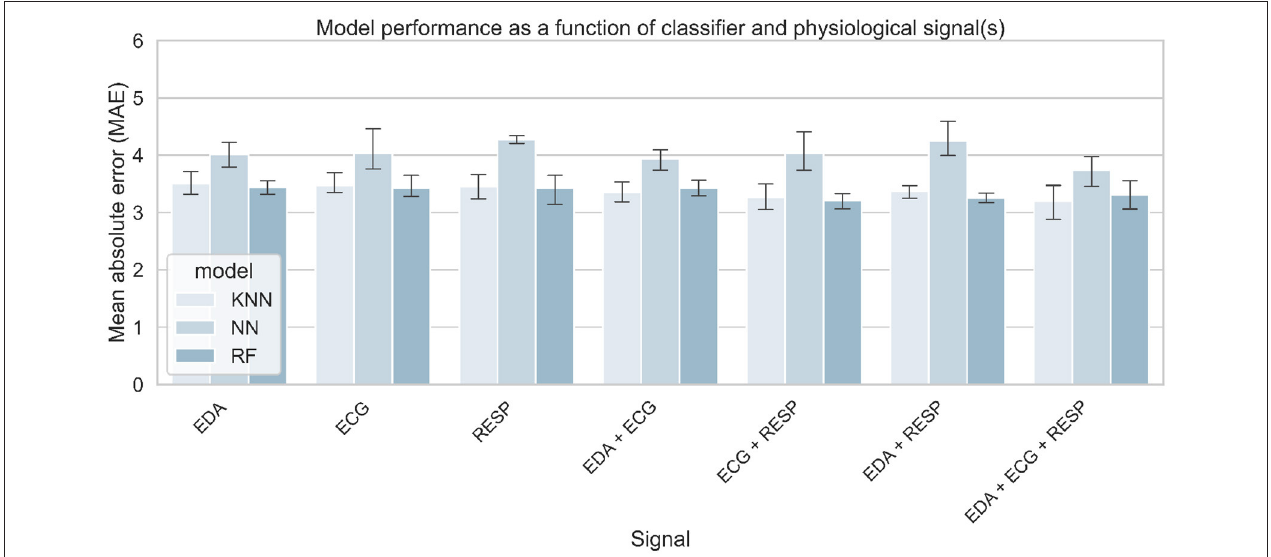
FIGURE 14 | Models’ performance for predicting MWL on a 0–20 scale, as a function of selected physiological signals and algorithm. A threshold for task performance of 100 was selected.